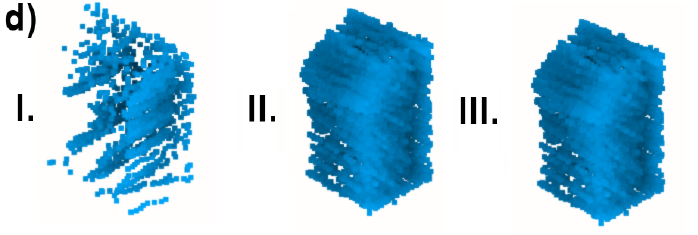
Figure 22. Point cloud resolution comparison for object (d)—isometric